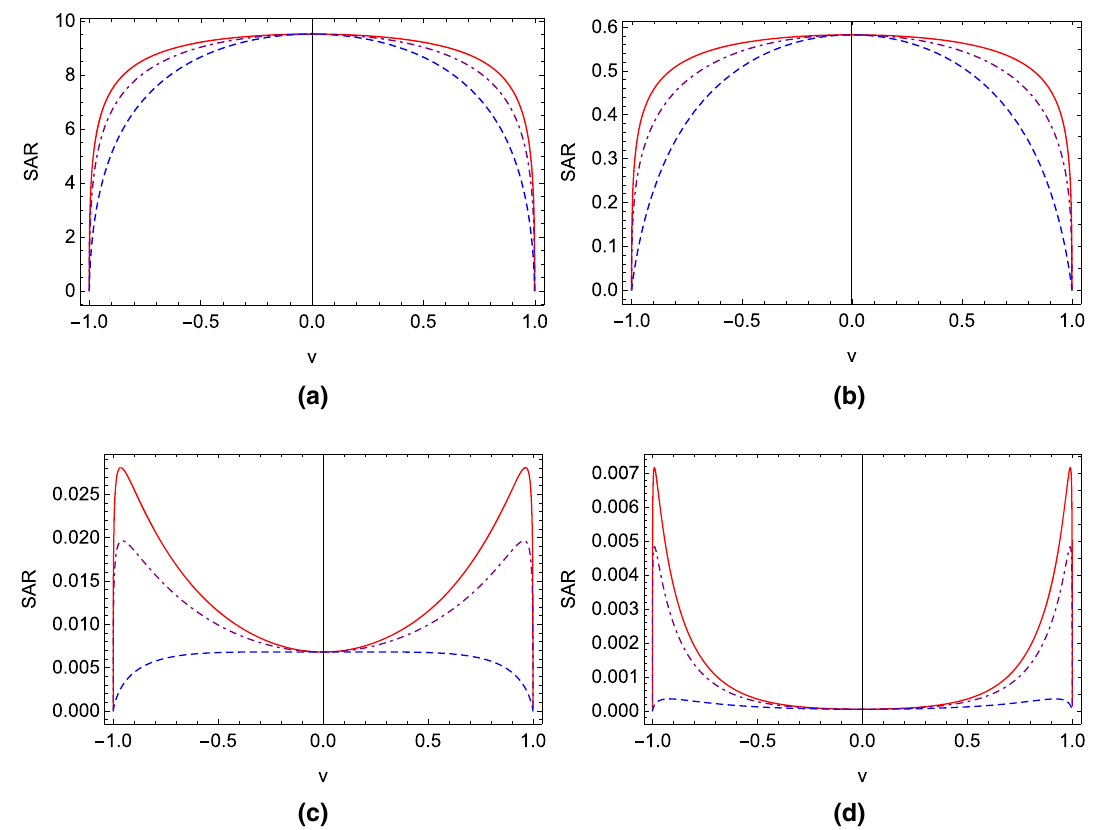
Fig. 1 Stimulated absorption rate of a uniformly moving atom in a thermal bath, as a function of the atomic velocity. The solid, dashed and dotdashed lines refer to the cases of α i = ( 1 , 0 , 0 ) (or α i = ( 0 , 1 , 0 ) ), α = ( 0 , 0 , 1 ) , and α = ( 1 , 1 , 1 ) , respectively. The atomic transition i i 3 3 3